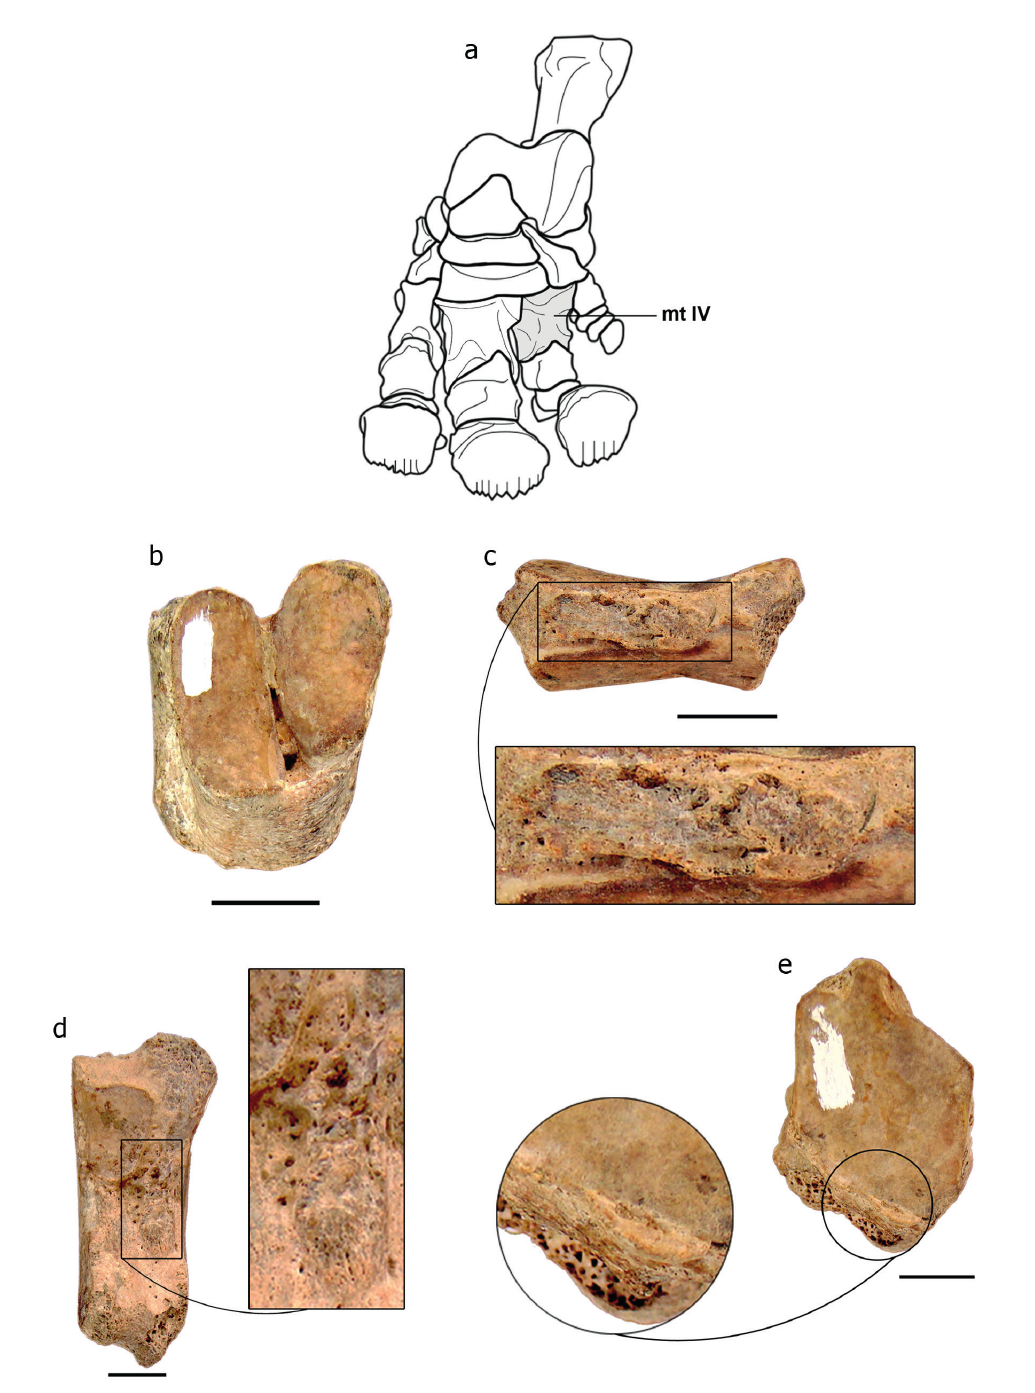
Figure 4 - ( a ) scheme of the foot of Panochthus sp. (modified from Burmeister, 1874); ( b ) right sesamoids (MCC 1559-V) associated with metatarsal III fused; ( c ) right mesocuneiform in lateral view with highlight of the lesion; ( d ) right sesamoid (MCC 1559-V) associated with metatarsal II in lateral view with highlight of the lesion; ( e ) proximal articulation of the metatarsal IV (MCC 1559-V) with highlight of the lesion. Scale bar = 2.0 cm. Abbreviation: mt IV: metatarsal